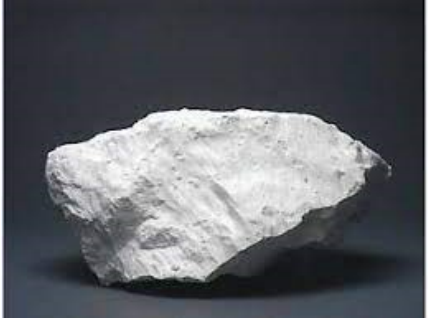
Figure 6. Photography of clay